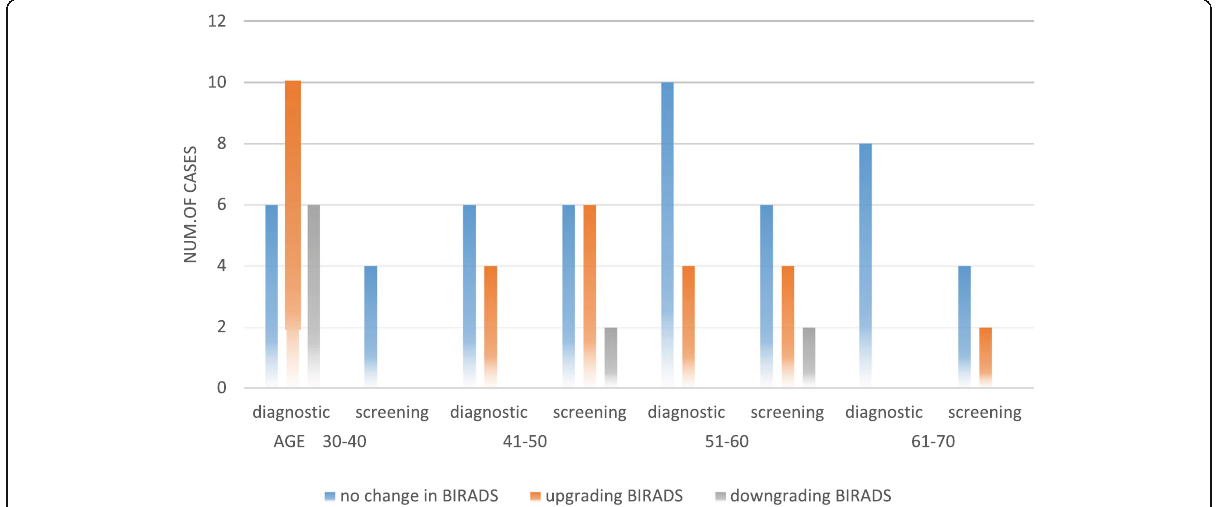
Fig. 8 Effect of addition of DBT to FFDM on BIRADS scoring in different age groups in diagnostic and screening